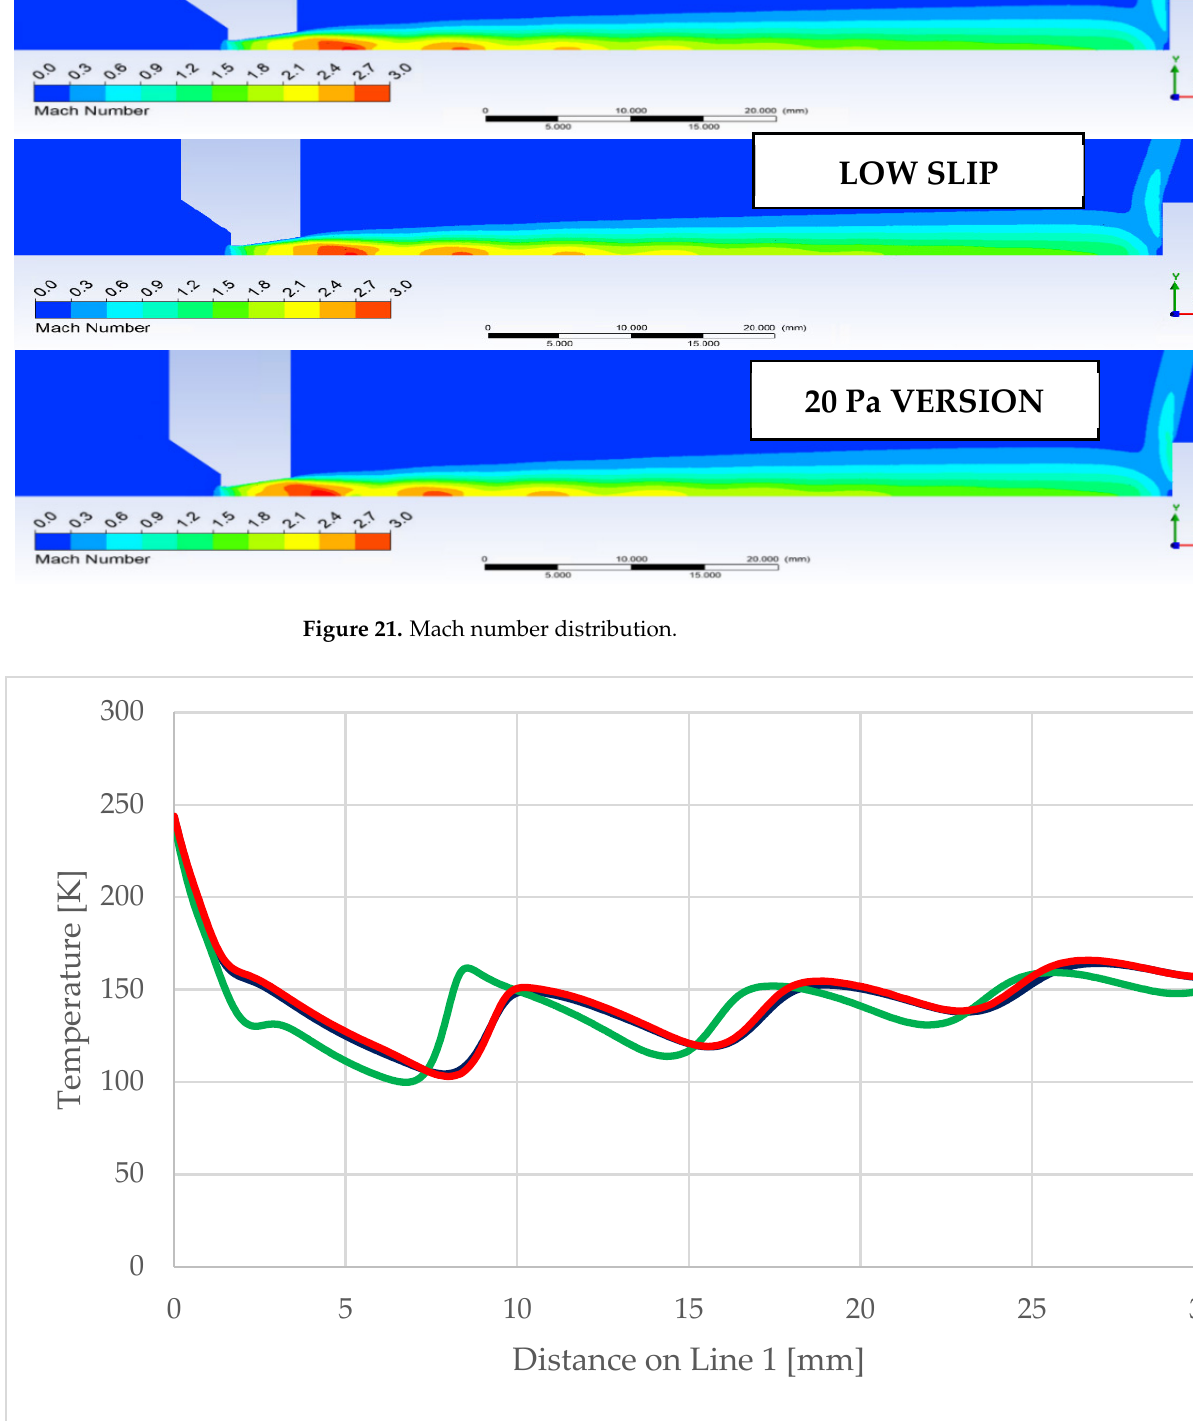
Figure 22. Static temperature evolution for the tested variants.